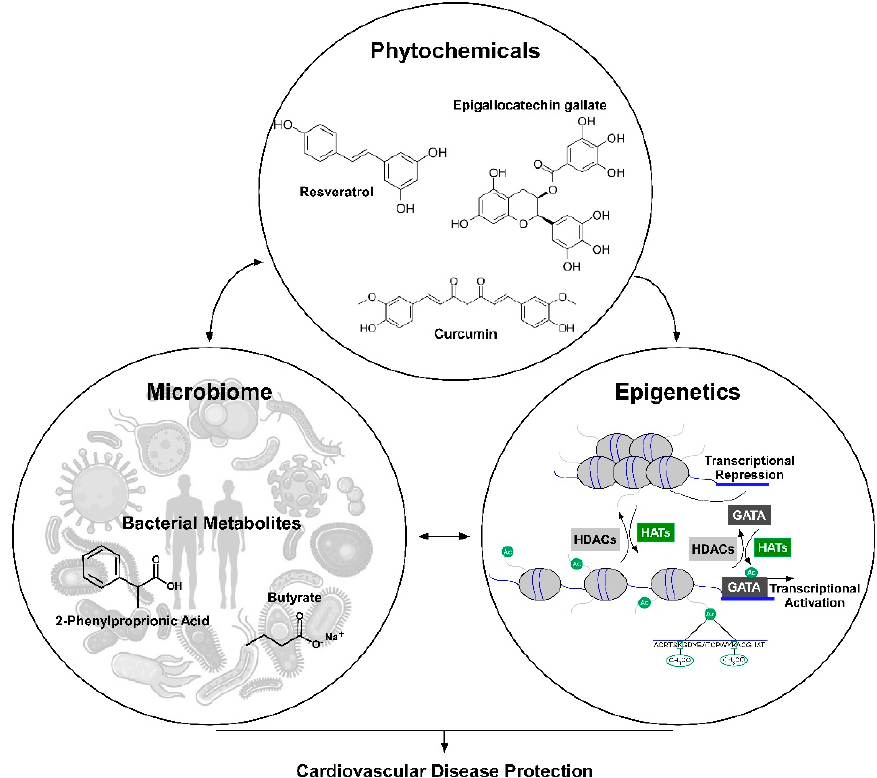
Figure 1. Model depicting the role for phytochemicals in the gut microbiota-histone acetylation axis in the regulation of cardiovascular disease protection. The phytochemicals curcumin, epigallocatechin gallate (EGCG) or resveratrol can alter the gut microbiome; this can promote healthy bacterial growth and bacterial metabolites needed for histone acetylation changes in the heart. The parent phytochemicals curcumin, EGCG, or resveratrol can directly regulate histone acetylation. The parent compounds or metabolites can alter histone acetylation or transcription factor activity by regulating enzymes responsible for the addition or removal of acetyl marks on lysine